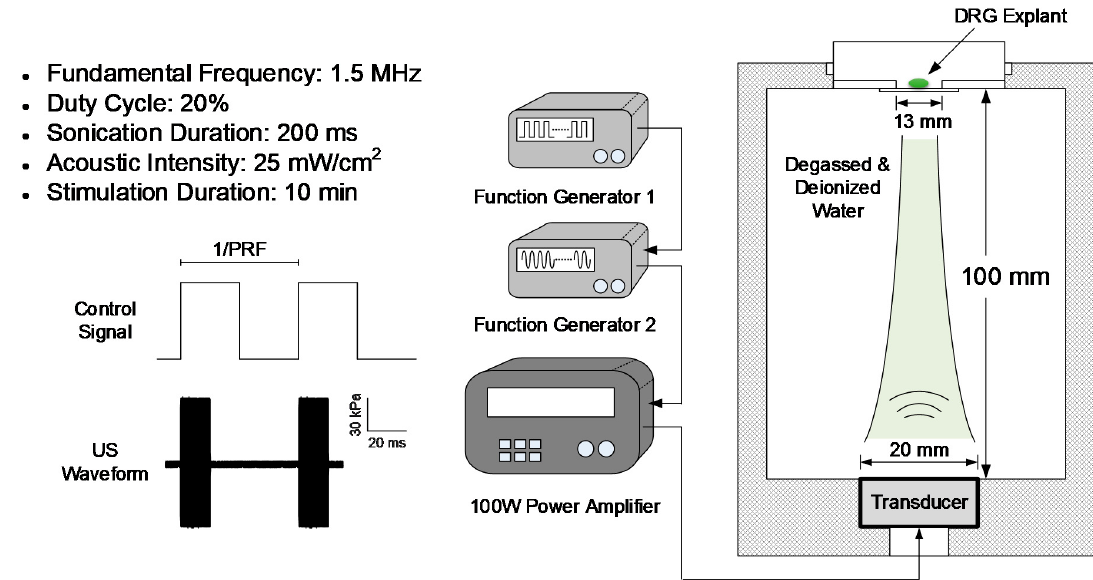
Figure 1. Experimental set-up for ultrasound stimulation (US). The dorsal root ganglion (DRG) explant was positioned 100 mm above the transducer. The chamber was filled with degassed and deionized water. The acoustic stimulation parameters were set to a fundamental frequency of 1.5 MHz, a sonication duration of 200 ms, a stimulation duration of 10 min, and an acoustic intensity of 25 mW/cm 2 .